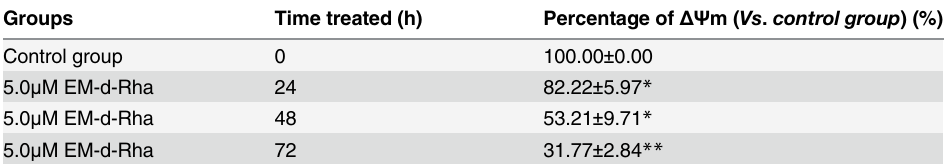
Table 7. Percentage of mitochondria membrane potential ( ΔΨ m) in HepG2 treated with EM-d-Rha in different times.